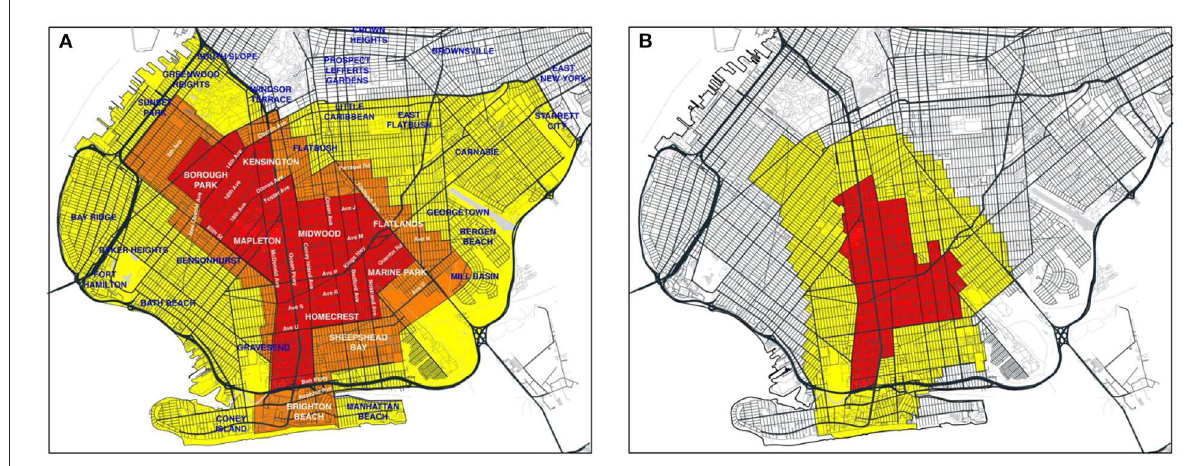
FIGURE1 (A) Red, orange, and yellow zones effective October 9, 2020 (29), Overlaid on Annotated Map of South Brooklyn. On October 21, the orange zone was re-designated as a yellow zone, while the red zone remained unchanged (30). (B) Revised boundaries of red and yellow zones as of November 3 (32). On November 9, the red zone was re-designated as an orange zone (27), and subsequently as a yellow zone on November 18 (28).